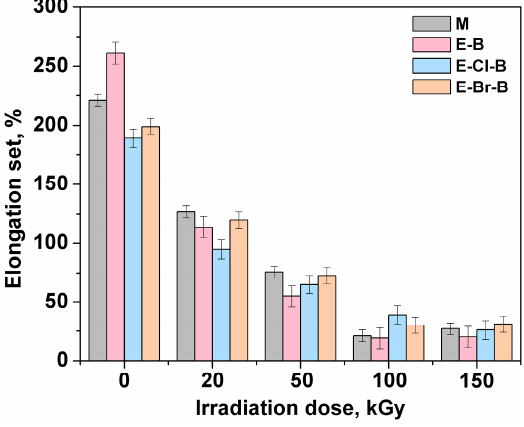
Figure 6. Variation of elongation at break of EPDM/butyl rubber composites with irradiation dose. Polymers 2018 , 10 , x FOR PEER REVIEW 8 of 21